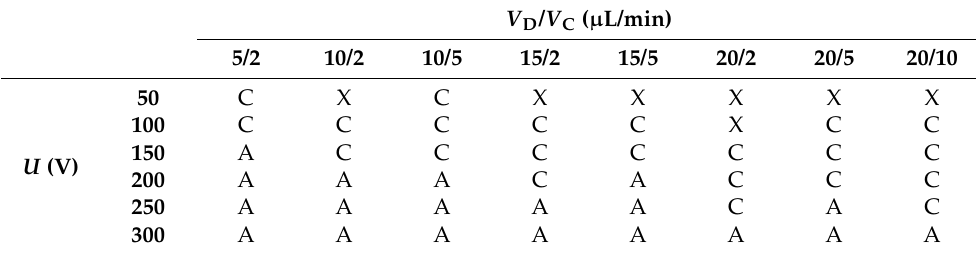
Table 2. Mapping the types of operations: Each experiment is specified by the value of the inserted voltage (V) and by the combination of the outlet volume flows (written as V D ⁄ V C in µ L/min). The three types of operation are denoted as C—continuous desalination, X—unsuccessful operation, and A—desalination by